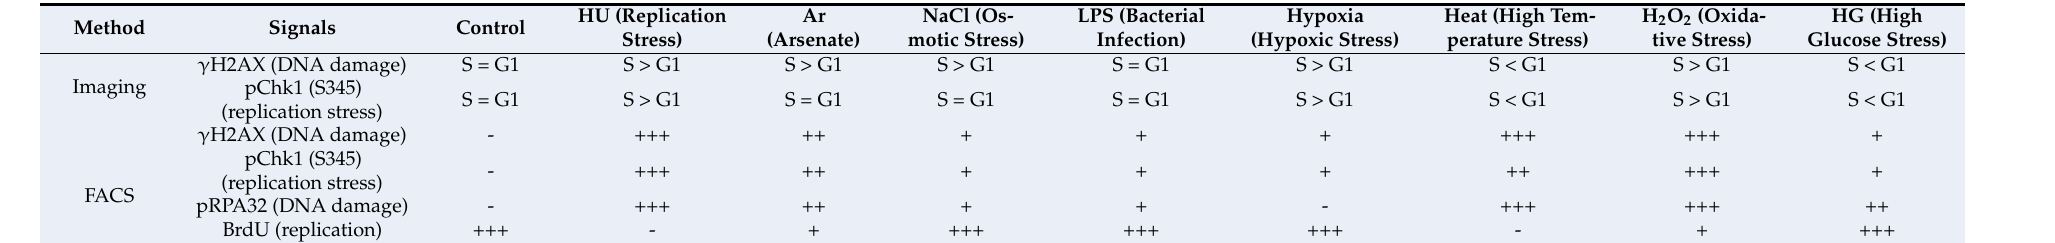
Table 2. Summary of γ -H2AX, pChk1(S345), pRPA32, and BrdU in cells treated with various biological stresses. In the rows of “imaging”, the description is made on the basis of the data from the numbers of foci-positive cells (left graph of Figure 1D,E). “S > G1” indicates that foci are observed in S phase cells (green) more frequently than in G1 phase (red). γ -H2AX: +++ >40 % cells positive, ++ >20%, + >10%; pChk1(S345): +++ >50%, ++ >30%, ++ >10%; pRPA32: +++ >25%, + >4%; -, same withor below